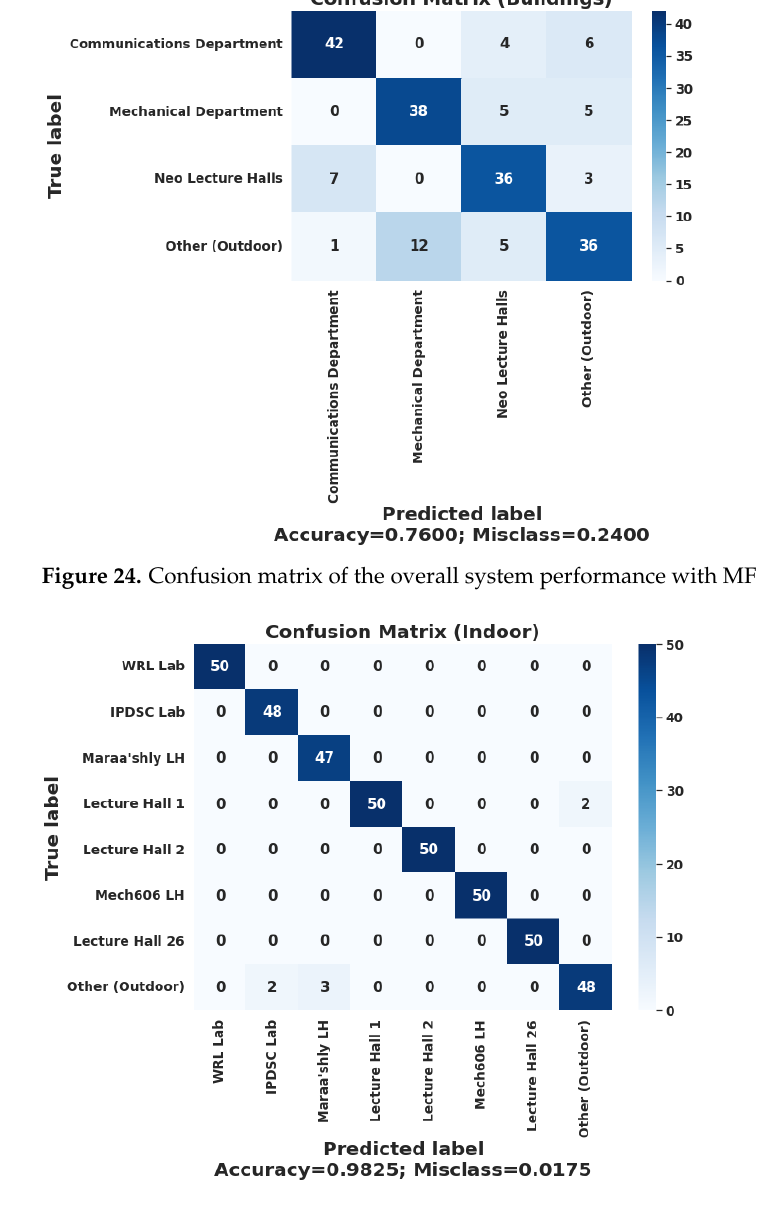
Figure 25. Confusion matrix of the overall system performance with WF-ML models.